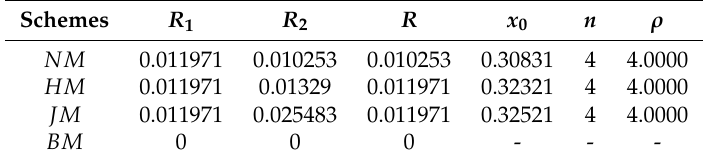
Table 1. Comparison on the basis of different radius of convergence for Example